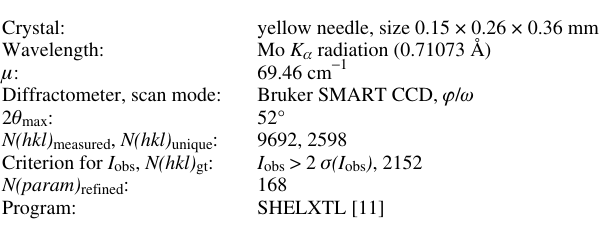
Table 1. Data collection and handling.